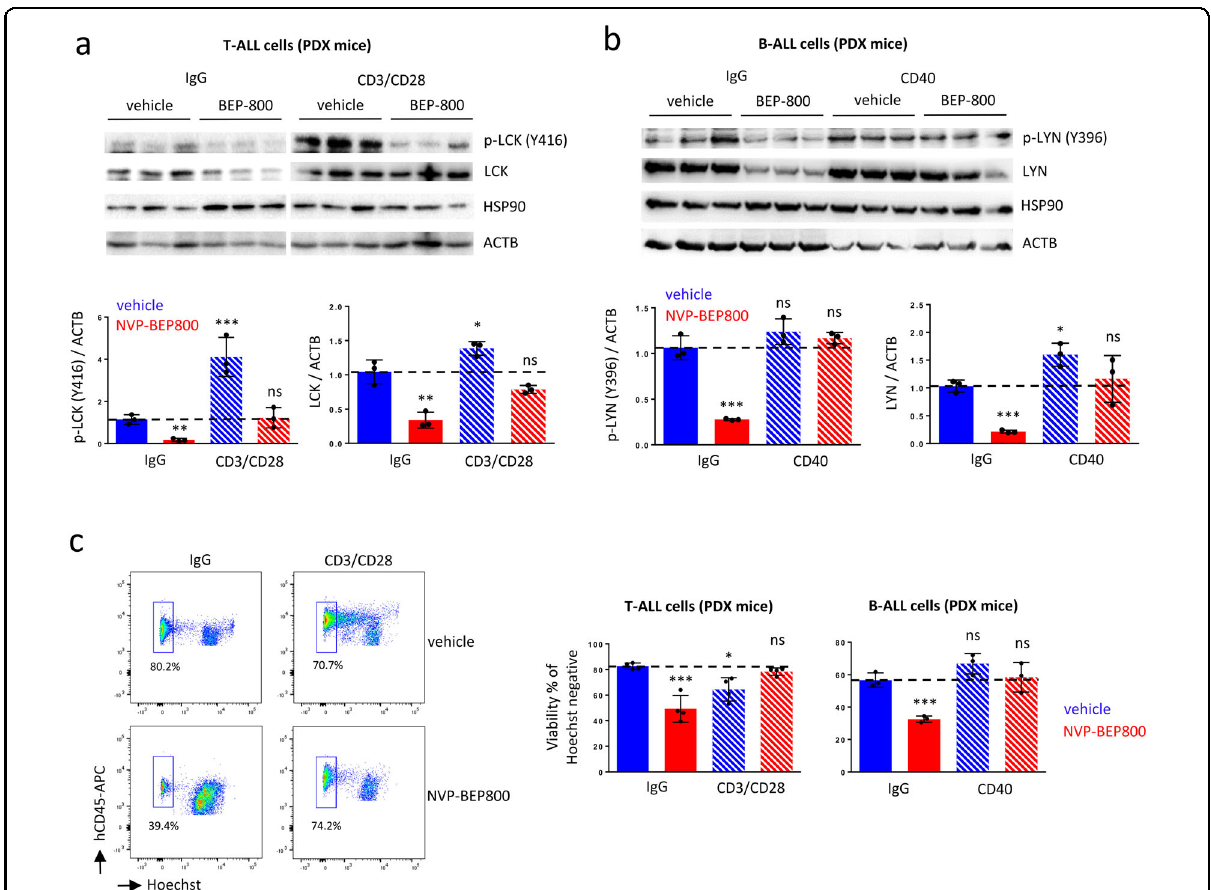
Fig. 6 Activation of LCK or LYN antagonizes the inhibitory effect mediated by NVP-BEP800 on T-ALL and B-ALL cells isolated from PDX mice. a Western blot shows that cross-linking with anti-CD3 (1 μ g/ml) and anti-CD28 (1 μ g/ml) antibodies (CD3/CD28) to activate the LCK kinase inhibits the effect of NVP-BEP800 and its capacity to reduce levels of p-LCK and LCK. Quanti fi cation of p-LCK (Y416) and LCK is normalized to ACTB (bottom panel). Data are shown as mean ± SD; n = 3 biological replicates. b Activation of the LYN kinase antagonizes the effect of NVP-BEP800. Western blot on PDX B-ALL cells pretreated or not with anti-CD40 (1 μ g/ml) antibody (CD40). Quanti fi cation of p-LYN (Y396) and LYN is normalized to ACTB (bottom panel). Data are shown as mean ± SD; n = 3 biological replicates. c Cytometry shows that activation of LCK or LYN antagonizes the inhibitory effect mediated by NVP-BEP800, on T-ALL and B-ALL PDX cells. After treatment with anti-CD3 (1 μ g/ml) and anti-CD28 (1 μ g/ml) antibodies (CD3/CD28) to activate the LCK kinase or anti-CD40 (1 μ g/ml) antibody (CD40) to activate the LYN kinase, ALL cells are treated with NVP-BEP800 (1 µM) for two days and the viability of ALL cells is recorded by fl ow cytometry after Hoechst staining. Data are shown as mean ± SD; n = 4 biological replicates for T-ALL and n = 3 biological replicates for B-ALL. In this fi gure, P -value measured by one-way Anova test with Tukey ’ s multiple comparison test; IgG vehicle is used as a reference; * P < 0.05; ** P < 0.01; *** P < 0.001; ns, non-signi fi